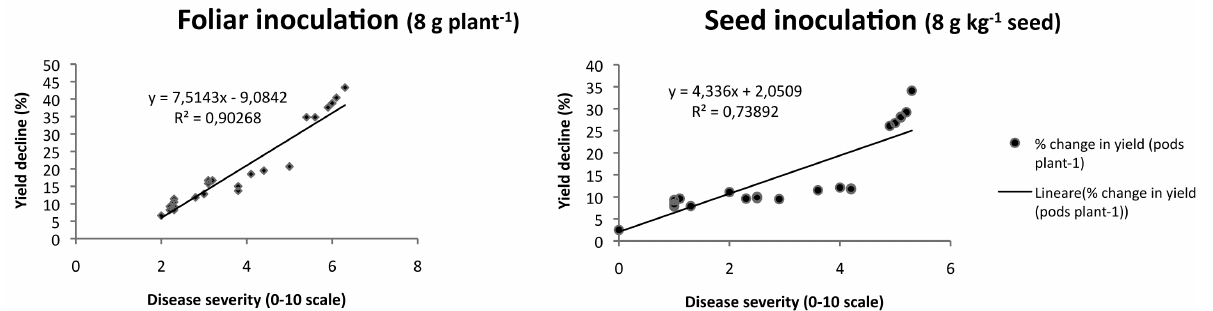
Figure 3. Correlation between disease severity and yield decline of chickpea cultivars subjected to foliar and seed inoculation with Botrytis